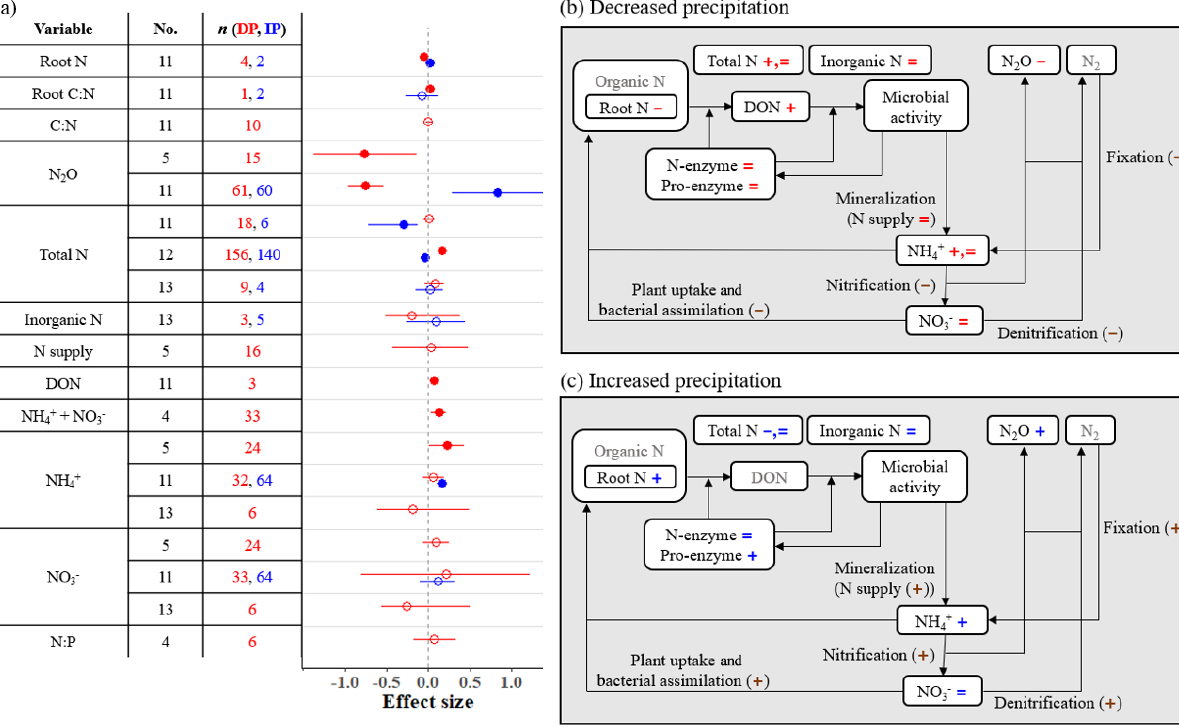
Figure 3. (a) Effect sizes for soil nitrogen variables responding to decreased (red) and increased (blue) precipitation. Filled points represent a significant effect size (95% CI not overlapping 0), and open points represent a nonsignificant effect size. Variable names correspond to Table 2. No. is meta-analysis number as listed in Tables 1 and 2. The sample size is indicated by n . (b,c) The effects of (b) decreased precipitation and (c) increased precipitation on a simplified schematic of the soil nitrogen cycle. Negative, positive, and nonsignificant effects are represented by − , + , and = , respectively. These symbols are colored in red and blue if variables are found in one or more meta-analyses. Brown symbols in parentheses represent variables that no meta-analyses have quantified; in these cases, we estimated the effects based on our review of empirical studies in Sect.